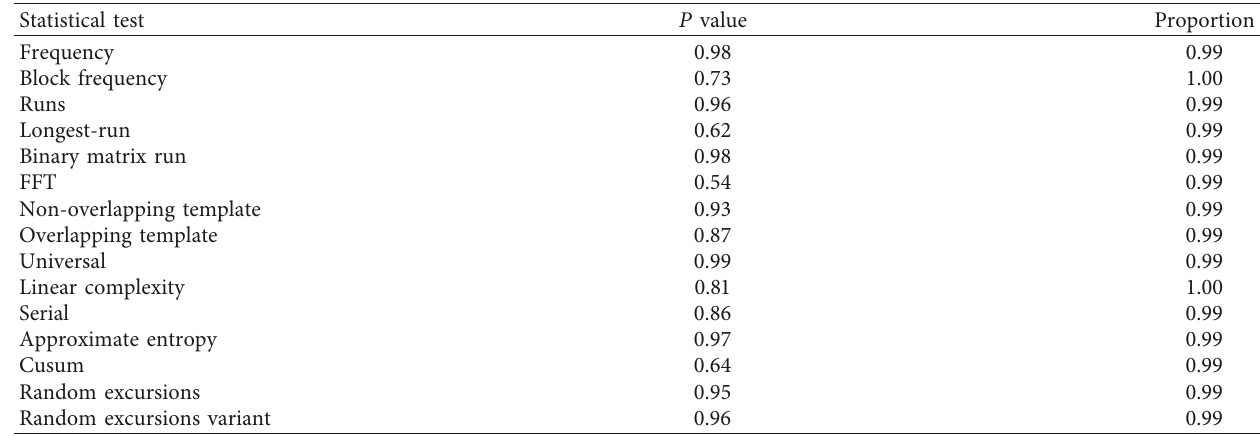
Table 1: Randomness measurement of the proposed method.